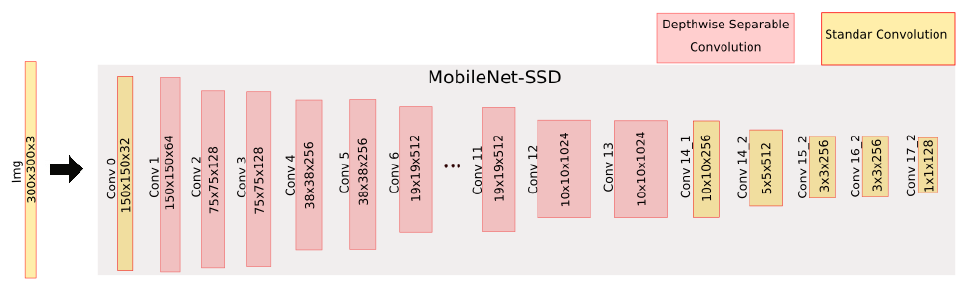
Figure 3. Data flow and multiple thread processing.